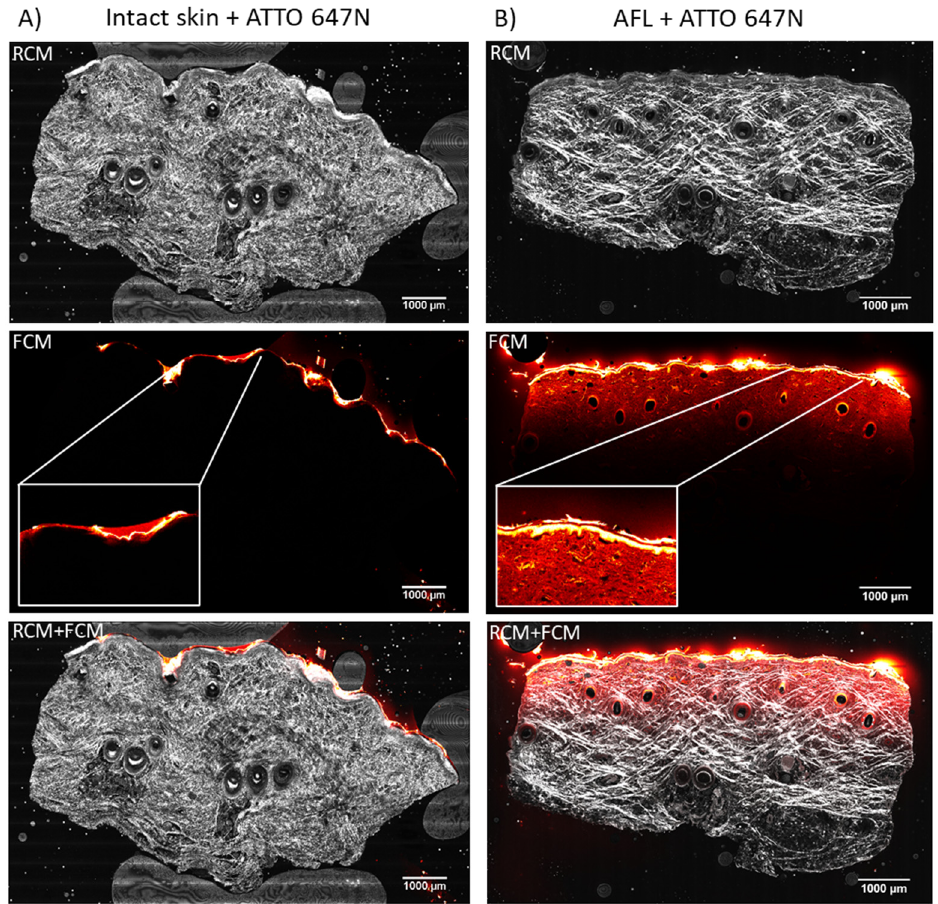
Figure 3. Cutaneous biodistribution of ATTO 647N (746 Da). Ex vivo confocal microcopy imaging of ex vivo porcine skin after 20 h passive diffusion in a Franz cell setup. ( A ) Vertical tissue sections of intact skin exposed to ATTO 647N ( n = 4). Images showed no uptake into the intact skin, but remnants of ATTO 647N on the skin surface (box with close-up) was clearly visible. ( B ) Tissue sections of AFL-treated skin with topically applied ATTO 647N ( n = 4). A homogenous, horizontal band-like dermal uptake that decreased with depth and reached a median tissue depth of 1317 µm was seen. In addition, an increased ATTO 647N concentration in epidermis was observed in the AFL-treated skin (box with close-up). LUT in ImageJ: Red Hot. AFL: ablative fractional laser. RCM: Reflectance mode. FCM: Fluorescent mode.